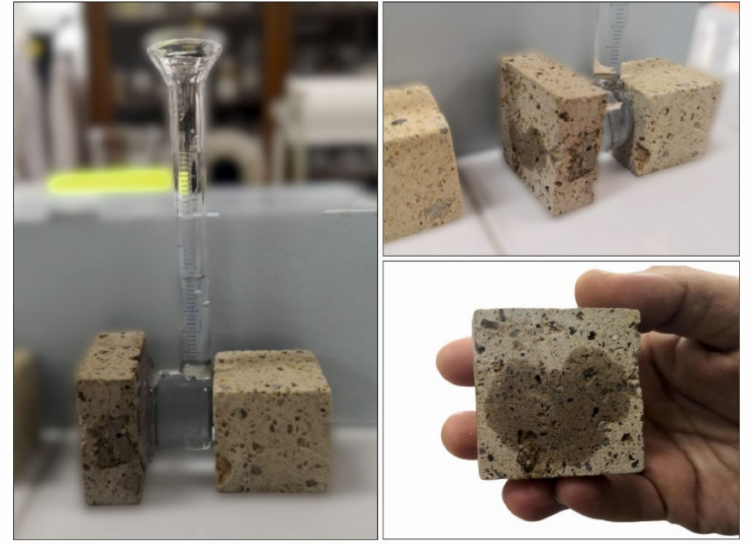
Figure 1. Measurement of water absorption under low pressure by pipe